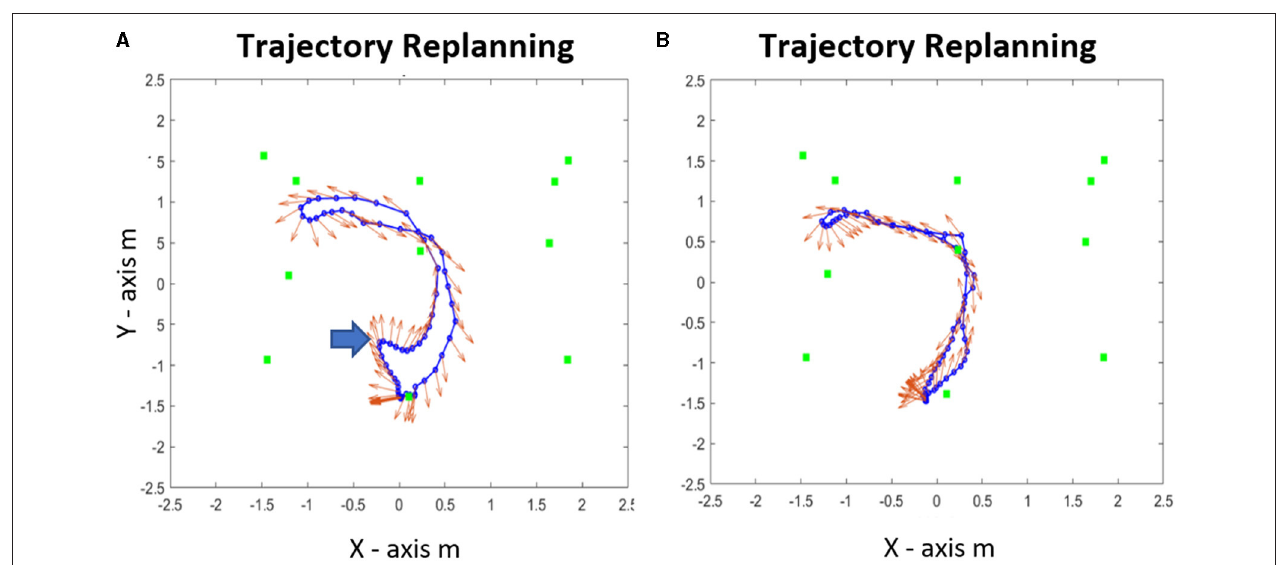
redirect the locomotion toward a new goal. In many